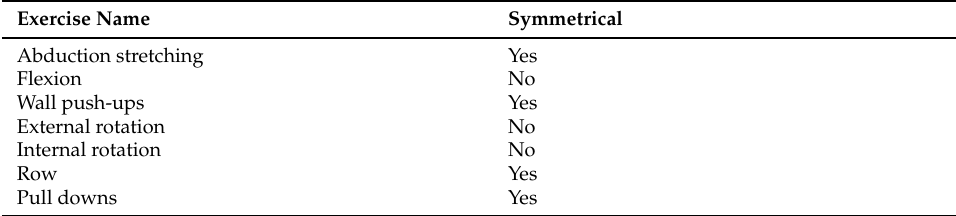
Table A1. Shoulder physiotherapy exercises used in the study.